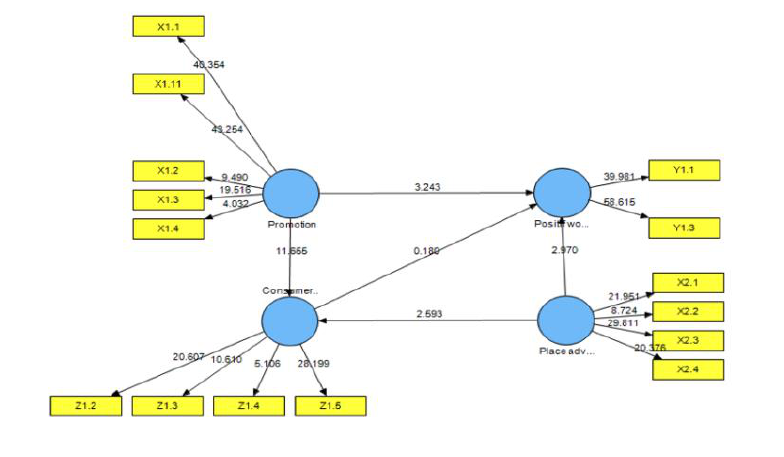
Figure 3: Structural model: Source: analysis results